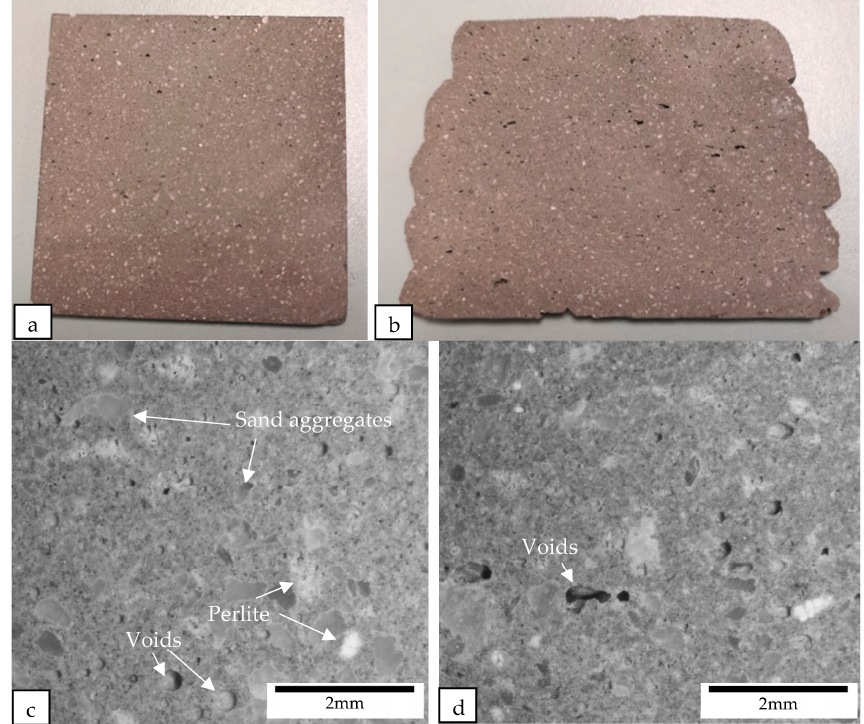
Figure 14. Cross-sectional images of ( a ) the cast and ( b ) the printed samples containing perlite aggregate replacement were obtained using a camera, while the macrostructure of the cross sections of ( c ) the cast and ( d ) the printed samples containing perlite aggregate replacement were examined under a microscope.